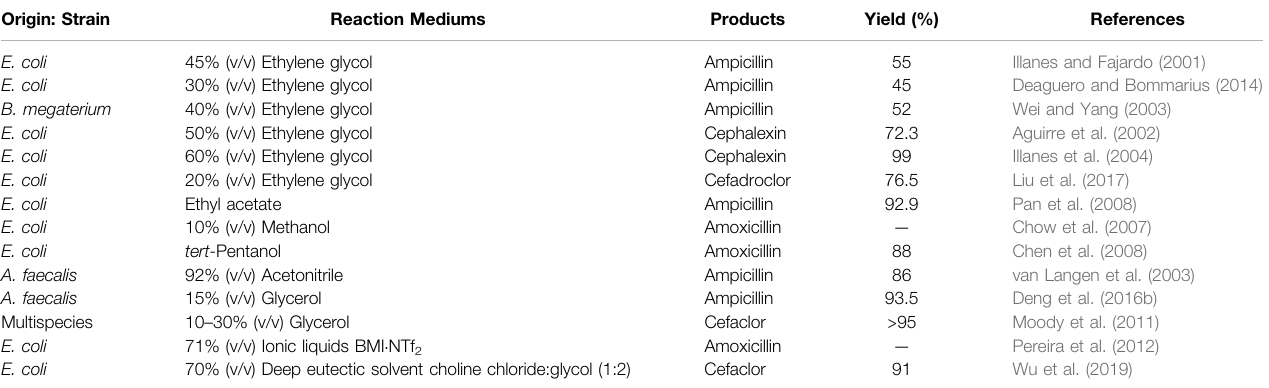
TABLE 3 | Effect of solvents on the kinetically controlled antibiotics synthesis by PGA. Origin: